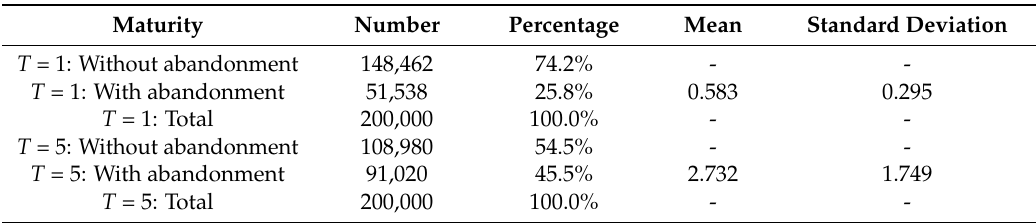
Table 6. Exercise of the option to